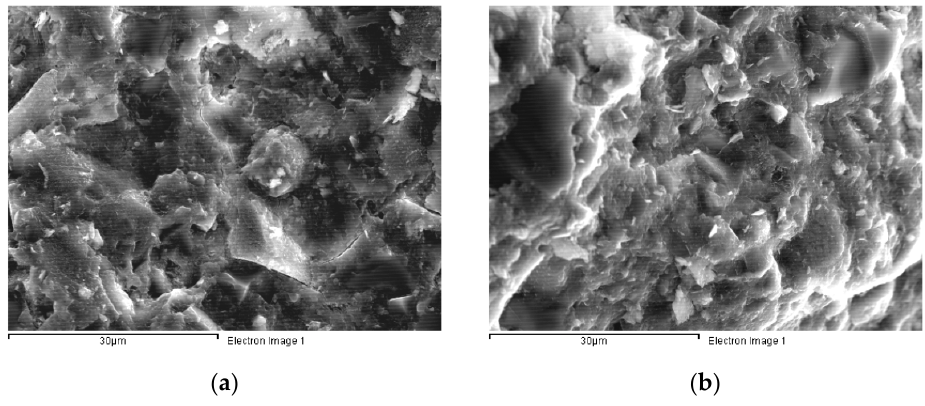
Figure 4. Micrographs (2000×) of concretes: ( a ) UH-2F-air; ( b ) UH-2F-90.